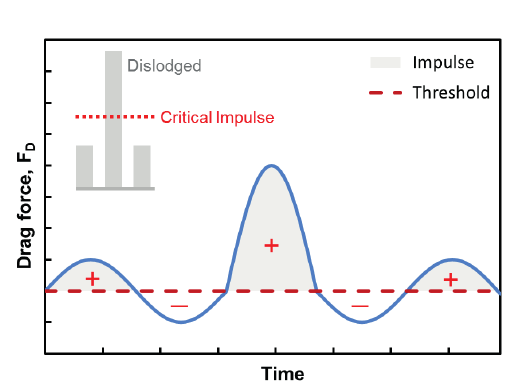
Fig. 1 Force parcels in impulse-based